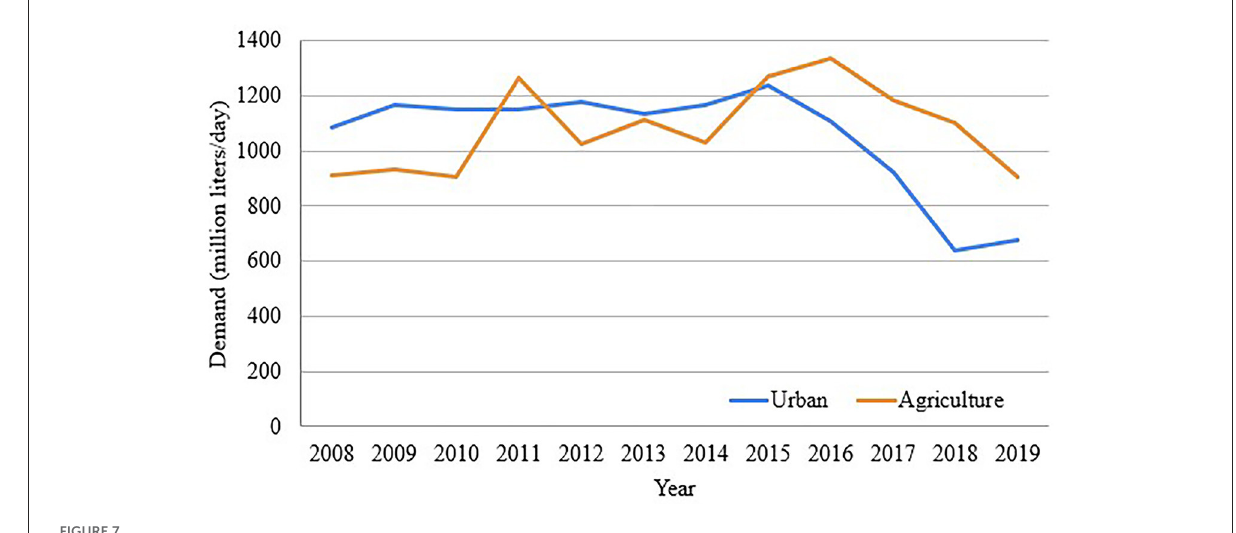
FIGURE7 “Big Six” dams monthly peak water use from 2008 to 2019.